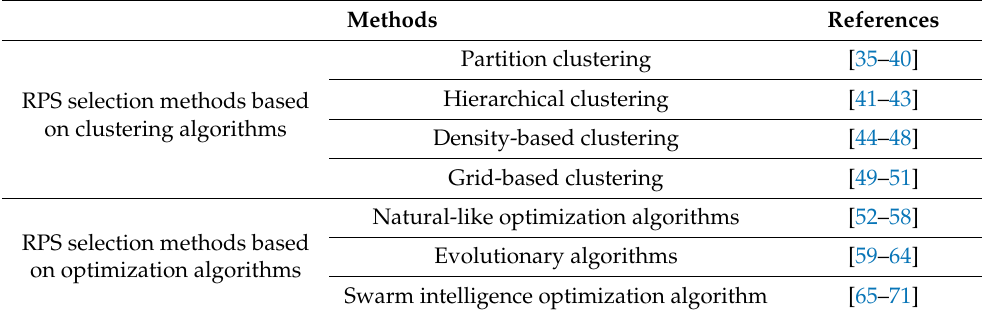
Table 2. Summary of algorithms applicable to RPS selection.